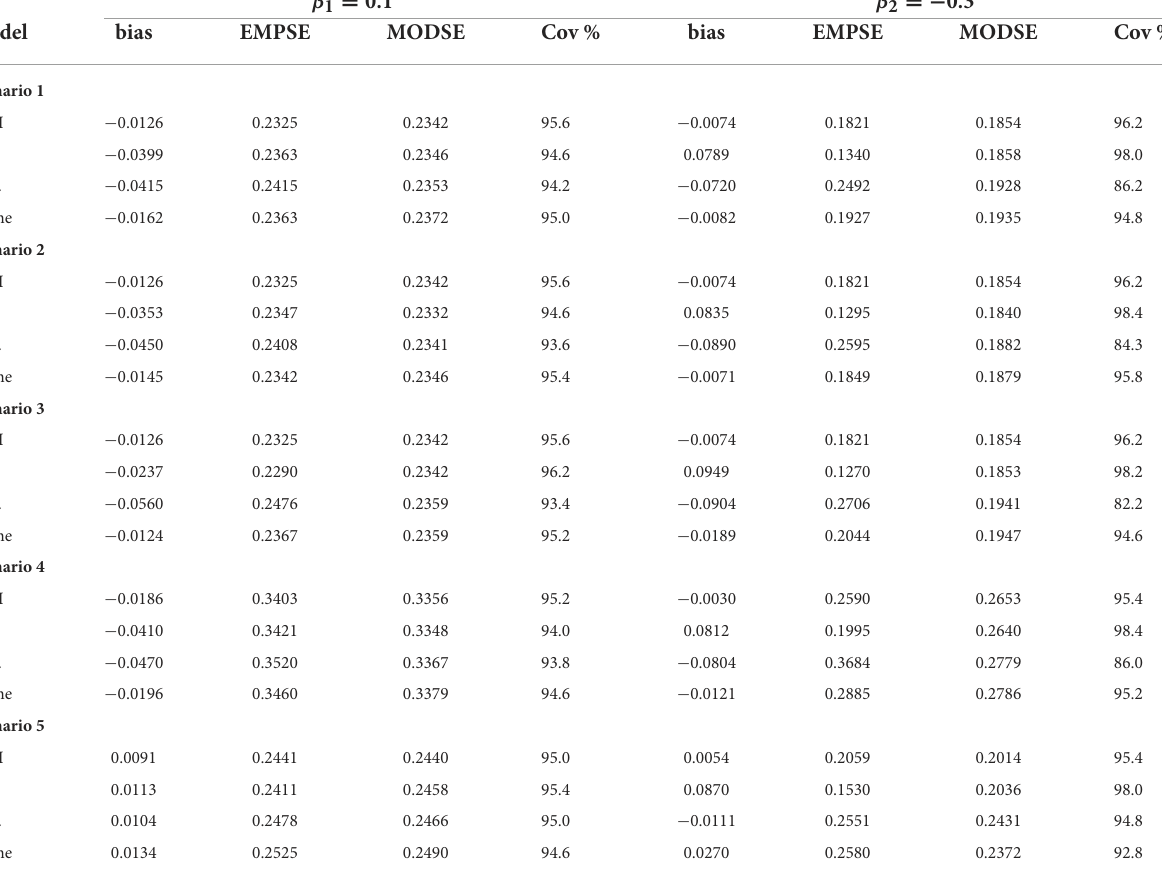
TABLE 1 Performance measures for all simulation scenarios.